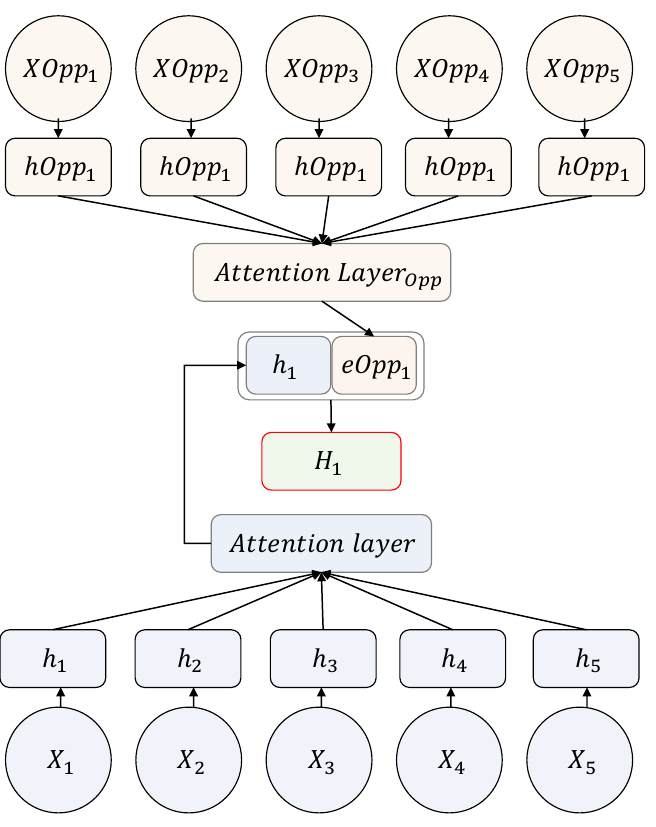
Figure 7. Overall neural network architecture for the multi-agent system: A network architecture expressing 10 multi-agent systems from the perspective of one agent. The feature of five agents in a cooperative relationship is e 1 , while the feature of five agents in a competitive relationship is h 1 . The feature of the entire multi-agent system is H 1 where e 1 and h 1 are